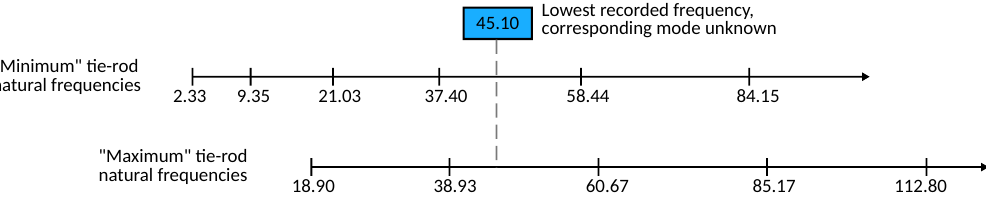
Figure 10. Mode order number guessing: example of the minimum and maximum tie-rods associated with the measured one. The lowest recorded frequency is compared with the ones from the two ideal tie-rods in order to restrict possible value of its mode order number to a specific range. In this example, the measured frequency could be the third, fourth or fifth of the tie-rod’s natural